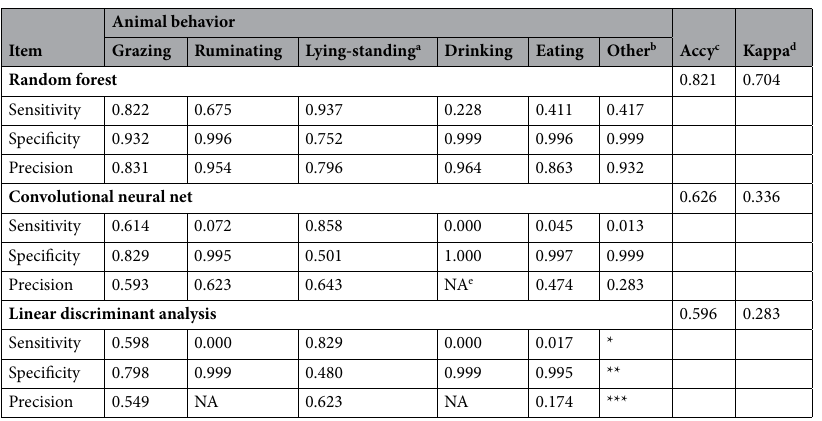
Table 2. Results from prediction (sensitivity, specificity, precision, accuracy and Kappa coefficient) through machine learning methods (random forest, convolutional neural net and linear discriminant analysis), of the different types of animal behavior observed (grazing, ruminating, lying-standing, drinking, eating and other activities) during both seasons (dry and wet). a Lying-standing: lying down + standing activities. b Other: Other activities. c Accy: accuracy. d Kappa: Kappa coefficient. e NA: not available.